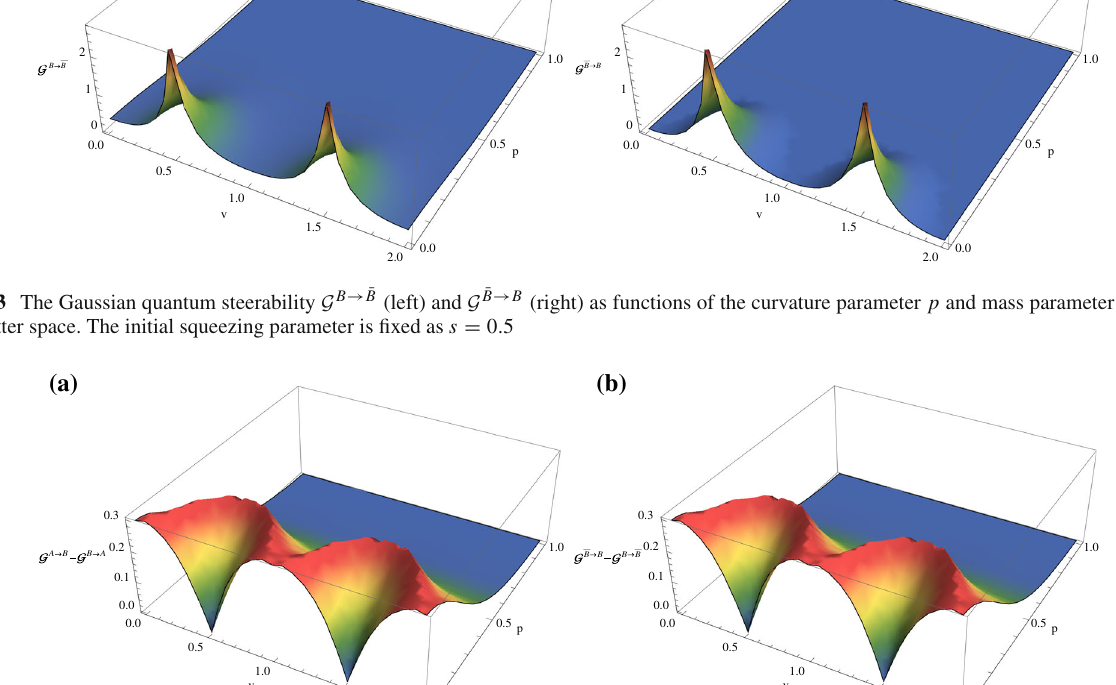
Fig. 4 The Gaussian steerability asymmetry between A and B (left), as well as the asymmetry between B and ¯ B (right) as functions of the curvature parameter p and mass parameter ν of the de Sitter space. The initial squeezing parameter is fixed as s = 0 .